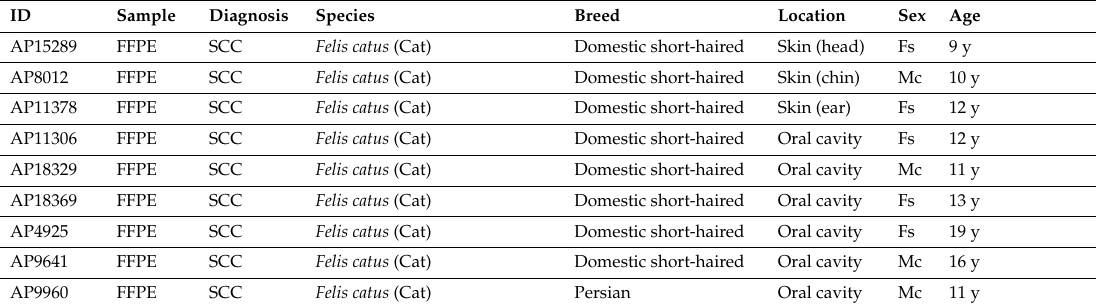
Table 1. Clinical details of mammalian species other than human included in this